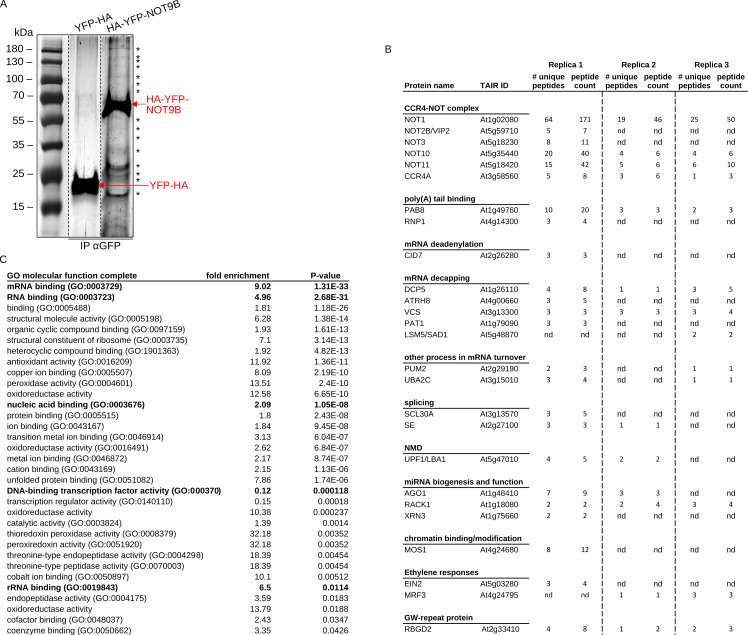
Investigation of the NOT9B interactome by AP-MS.(A) Immunoprecipitation of NOT9B associated proteins. Arabidopsis seedlings expressing p35S:HA-YFP-NOT9B (NOT9Box, line 21c) or p35S:YFP-HA were grown for 4 days in the dark and exposed to FR light for 5 hr. Total soluble protein was extracted and IP was performed using αGFP coupled magnetic beads. Eluate fractions were analysed by SDS-PAGE followed by silver staining of the gel. Bands specifically detected in the HA-YFP-NOT9B eluate fraction are labelled (*) and position of HA-YFP-NOT9B and YFP-HA is indicated. (B) List of selected proteins associated with NOT9B. Eluate fractions as in (A) were analysed by LC-MS/MS. Selected hits of the MS/MS analysis identified exclusively in the HA-YFP-NOT9B eluate fractions are listed with their unique and total peptides counts. nd, not detected. (C) GO term analysis of proteins enriched in the HA-YFP-NOT9B eluate fraction.